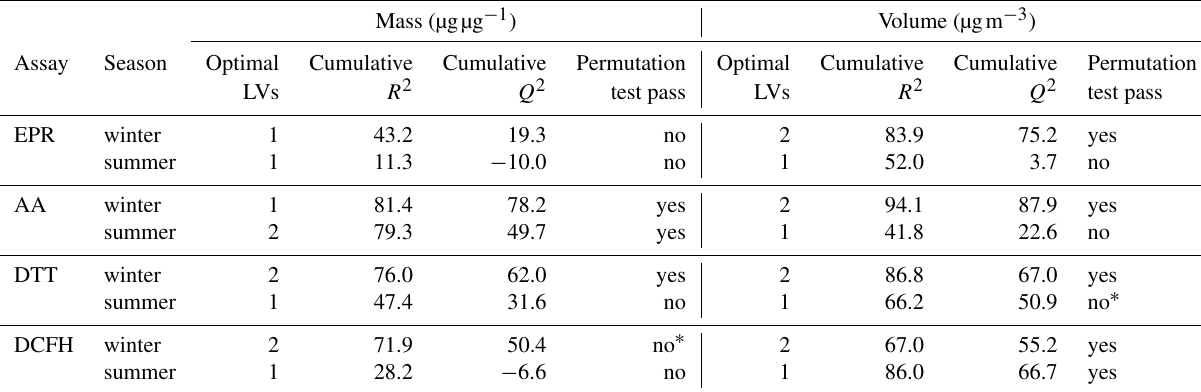
Table 2. Performance assessment of PLSR models for all assays, for both mass-normalised and volume-normalised data. Models are consid- ered to perform well when both cumulative (i.e. across all latent variables included in the model) R 2 and Q 2 values are high, or at a minimum where Q 2 values are within 10% of the R 2 value, indicating that the variance is well accounted for in model cross-validation. Permutation tests were rejected for robustness if any single random permutation model performance surpassed the performance of the real cross-validated model; on this basis, the winter DCFH m and summer DTT v models were rejected (highlighted with ∗ ), although fewer than three random models outperformed the real model, and none of the permuted model Q 2 values outperformed those of the real model. Mass (µgµg − 1 ) Volume (µgm − 3 ) Assay Season Optimal Cumulative Cumulative Permutation Optimal Cumulative Cumulative Permutation R 2 Q 2 test